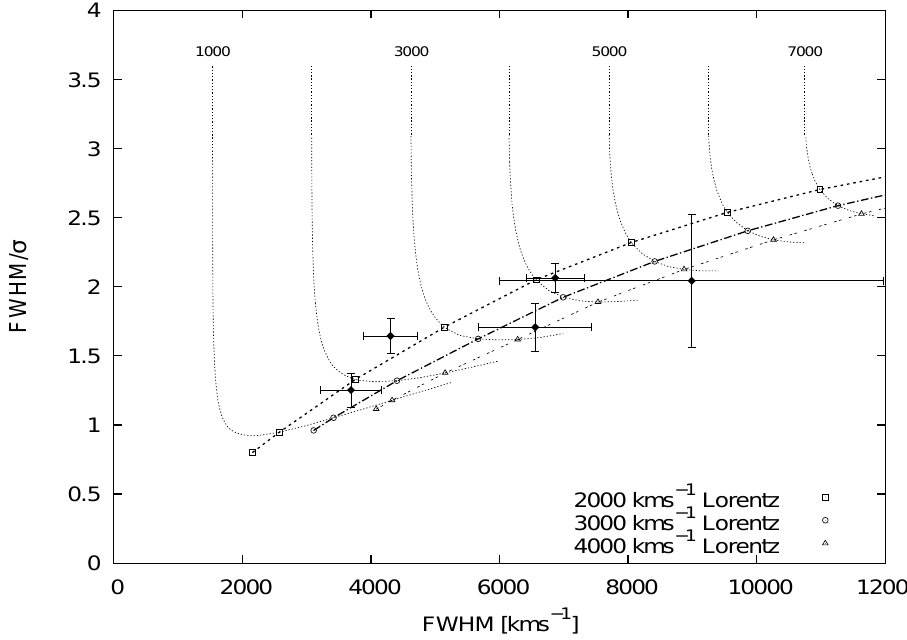
Fig. 3. The observed C IV (cid:21) 1550 linewidth ratios FWHM/ (cid:27) line versus their FWHMs from Peterson et al. (2004). Shown are only those measurements that were regarded as being reliable by the authors. The dashed curves show theoretical linewidth ratios of rotational line broadened Lorentzian profiles; the FWHMs are 2000 km/s (squares), 3000 km/s (circles) and 4000 km/s (triangles). The associated rotation velocities range from 1000 to 7000 km/s (curved dotted lines, from left to right) (Kollatschny & Zetzl